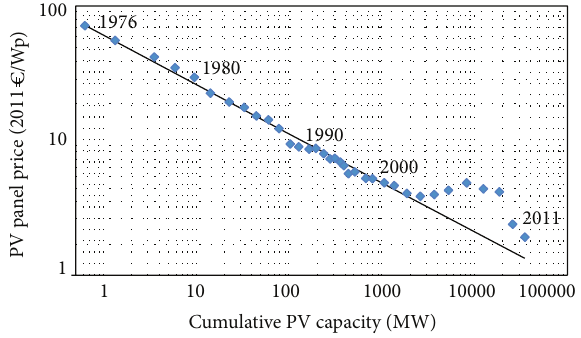
Figure 6: Learning curve for photovoltaic panel price development with 22% learning rate